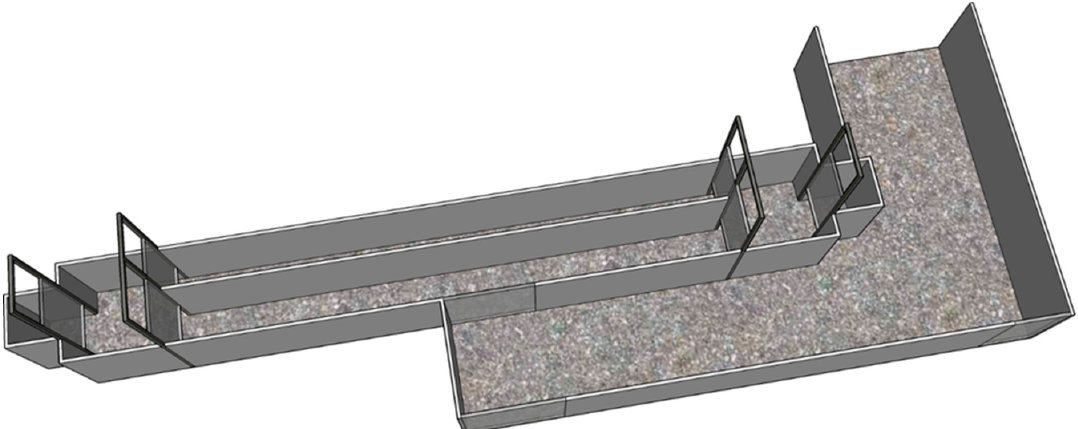
Figure 1. Schematic illustration of the experimental setup of the runway containing a pressure mat. The pressure mat was positioned exactly half-way in the runway at the back (furthest away from the penmates in the holding area). The cameras were positioned on the top of the frames of the guillotine doors on either side of the runway.